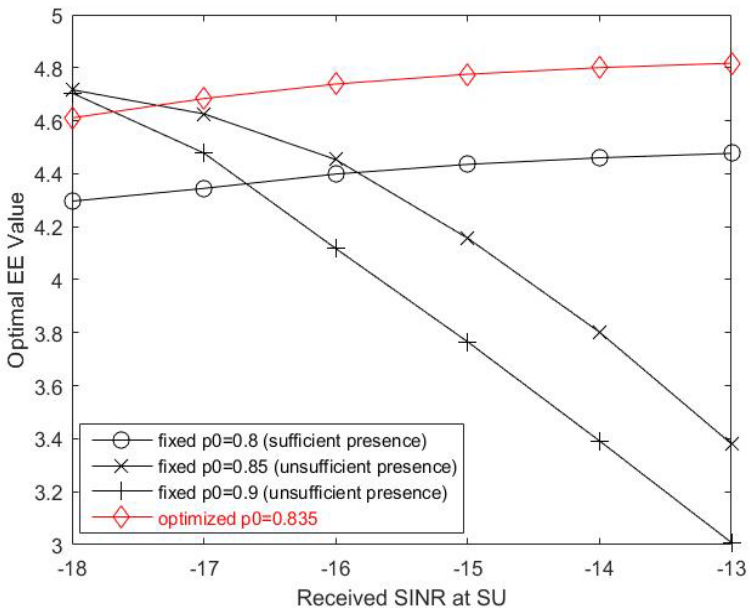
Figure 11. Comparison of EE with different PU activities.